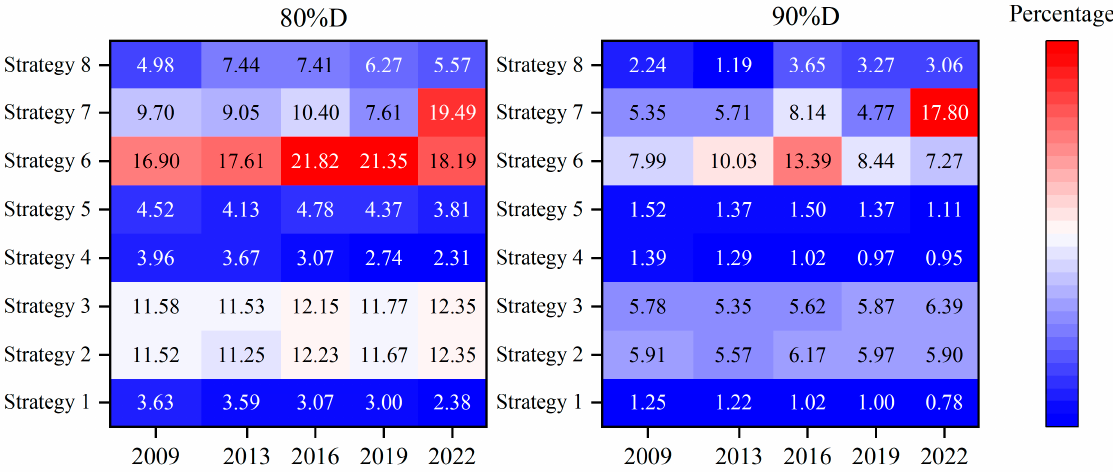
Figure 4. Relationship between the effectiveness of D-value and the failure ratio of each disturbance strategy.